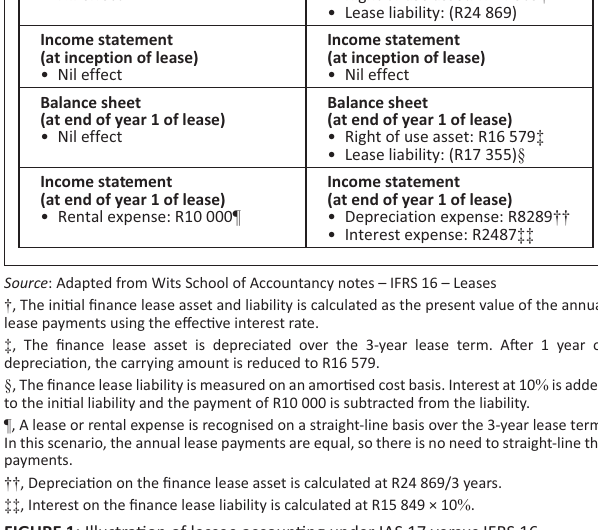
FIGURE 1: Illustration of lessee accounting under IAS 17 versus IFRS